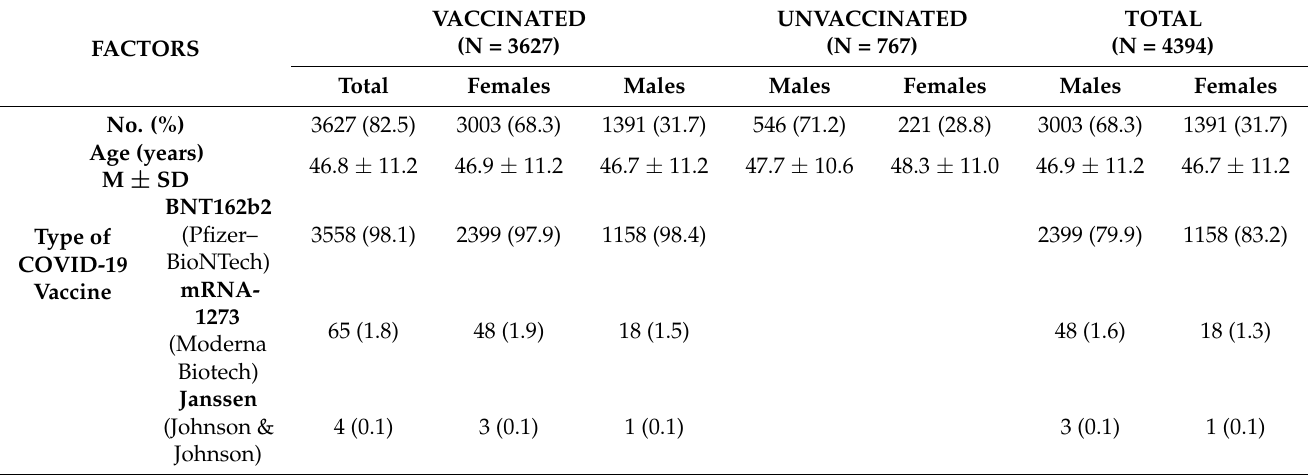
Table 1. Distribution of study population by age, sex of heath care workers, vaccination status and type of COVID-19 vaccine administered. Number (N), row percentage